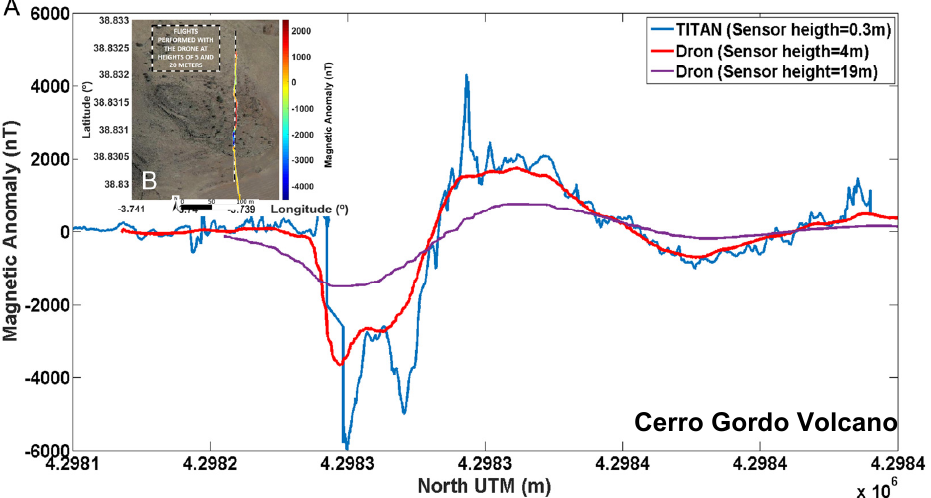
Figure 12. ( A ) Representation of the measurements performed with the ground equipment (TITAN) and with the drone at different heights. ( B ) Track followed by the ground equipment and magnetic anomaly in a color diagram.